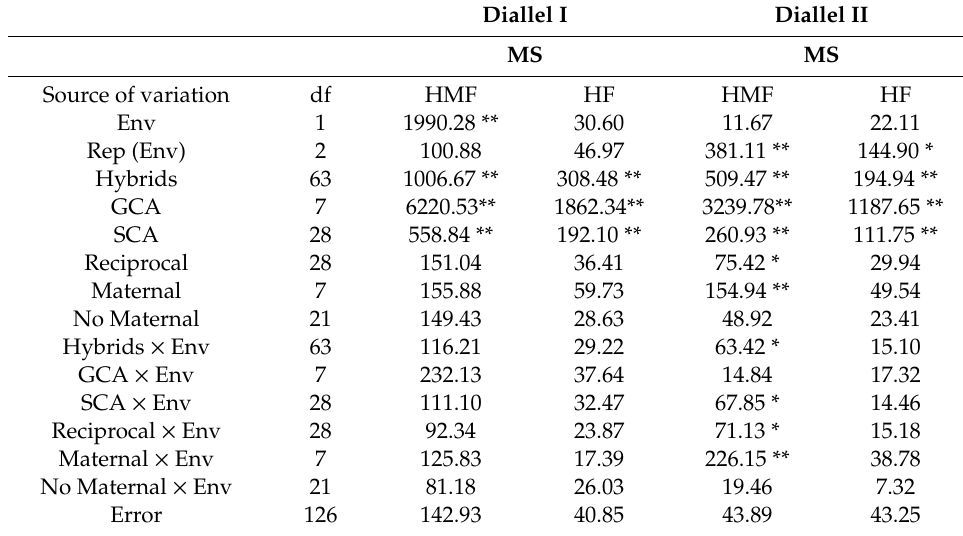
Table 3. Mean squares for general combining ability (GCA) and reciprocal, maternal, nonmaternal, and specific combining ability (SCA) and their interactions with environment for maize haploid male fertility (HMF) and haploid fertility (HF). Diallel I Diallel II MS MS